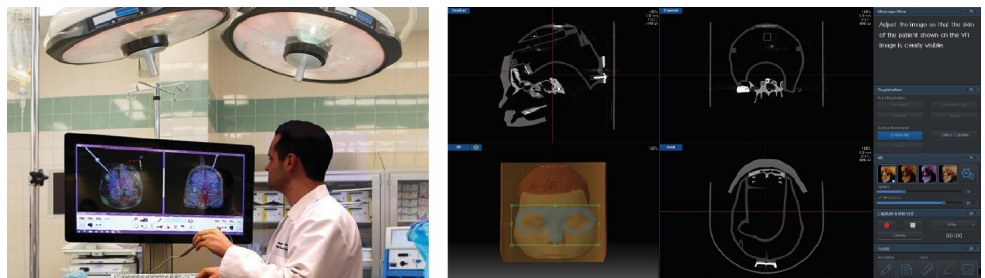
Figure 8. Sinus surgical navigation